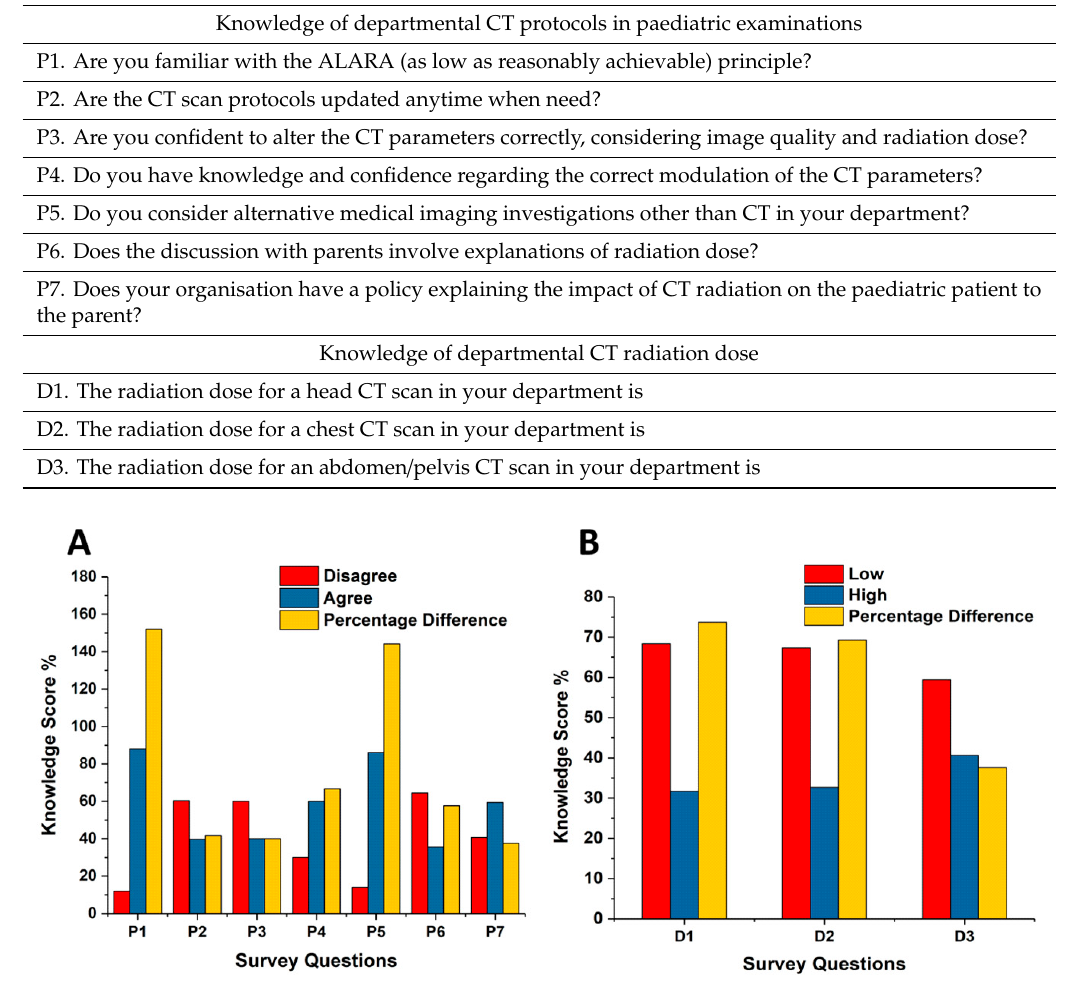
Table 2. Evaluation of radiologists’ knowledge of departmental CT radiation dose and CT protocols in paediatric examinations.